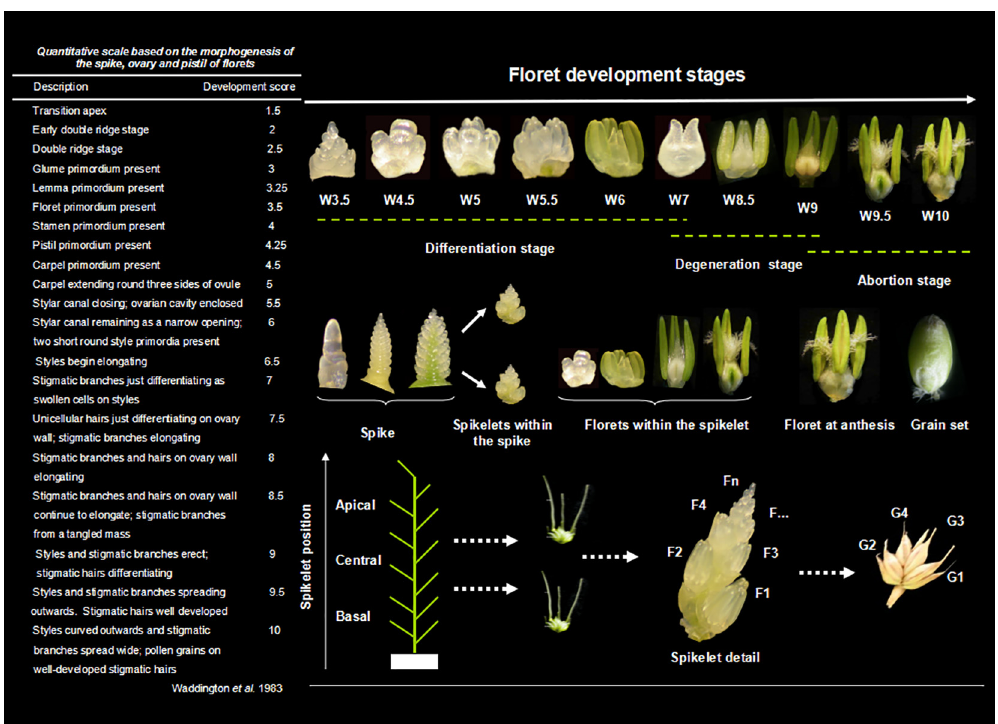
Fig 1. Development of the floret primordia. Floret developmental stages were determined using the Waddington scale [28] (left panel), with pictures captured using a stereomicroscope (XTZ-E BM (180x)). The panel on the upper right side illustrates floret developmental dynamics in three stages: differentiation (from the first appearance of floret primordium [W3.5] to the end of floret initiation [W7]), degeneration (i.e., the tetrad stage of floret development, from W7 to W9), and abortion (from pollen maturity [W9] to grain setting). The central panel first depicts the development of spikelets within the spike. Second, the development of floret primordia within spikelets is presented. Third, a floret successfully reaching the final fertile stage at flowering (W10) and grain setting is presented. The bottom panel illustrates the spikelet positions within the spike (left), the florets within spikelets from those closest to the rachis (F1) to those located at increasingly distal positions (middle), and the set grains numbered according to their positions relative to rachis, from G1 (the most proximal) to G4 (the most distal) (right). The drawings and pictures are not to scale: as a reference, the floret widths are approximately 0.15 mm in W3.5, 0.20 mm in W5, 0.50 mm in W7, 0.90 mm in W8.5, and 2.20 mm in